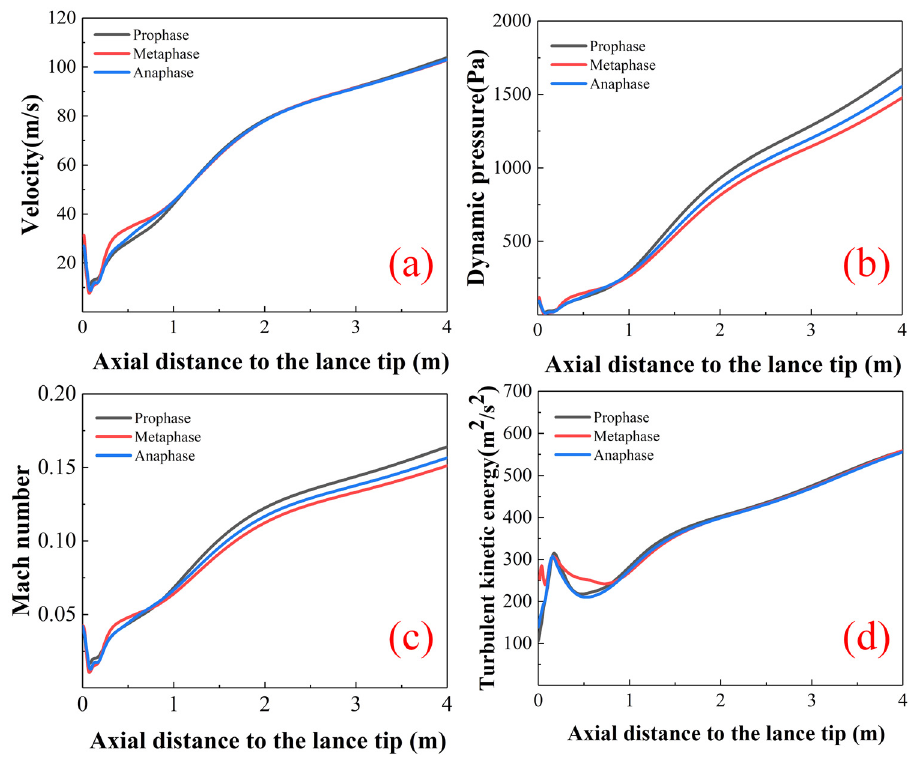
Figure 10: Jet characteristics of the nozzle centerline under di ff erent atmosphere conditions: ( a ) velocity, ( b ) dynamic pressure, ( c ) Mach number, and ( d ) turbulent kinetic